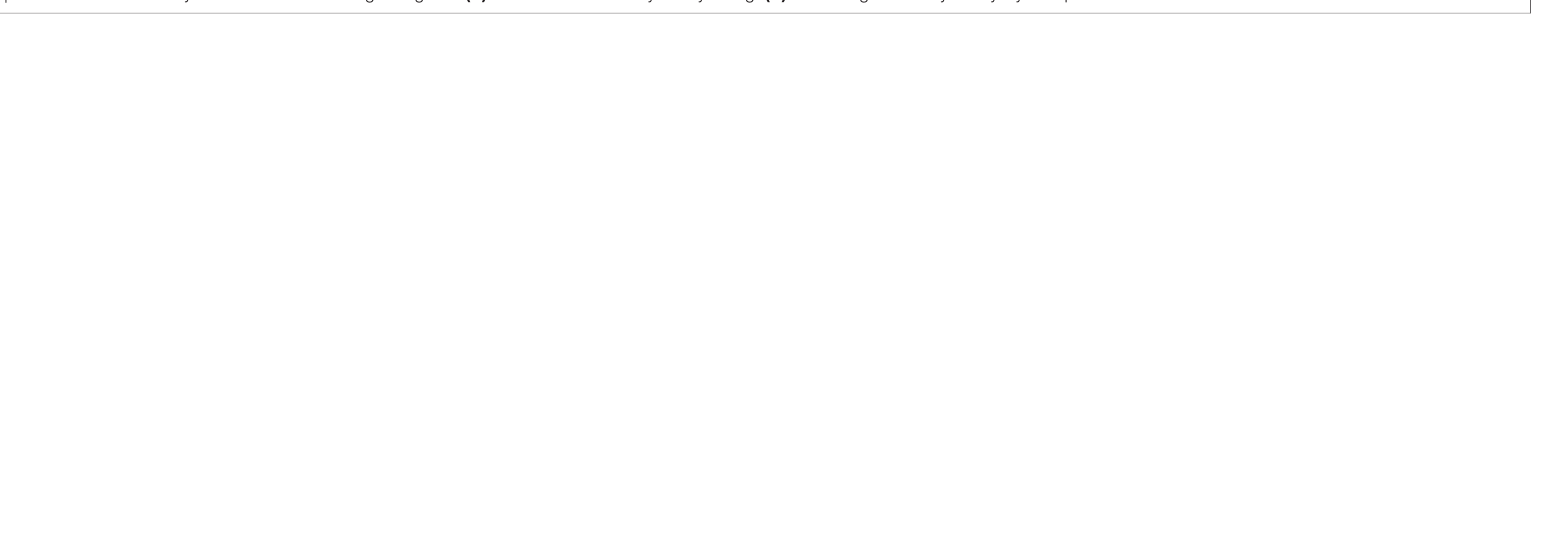
FIGURE 9 | The PPI of CXCR family members and their neighbor genes (A) the PPI network analyzed by String. (B) The hub genes analyzed by